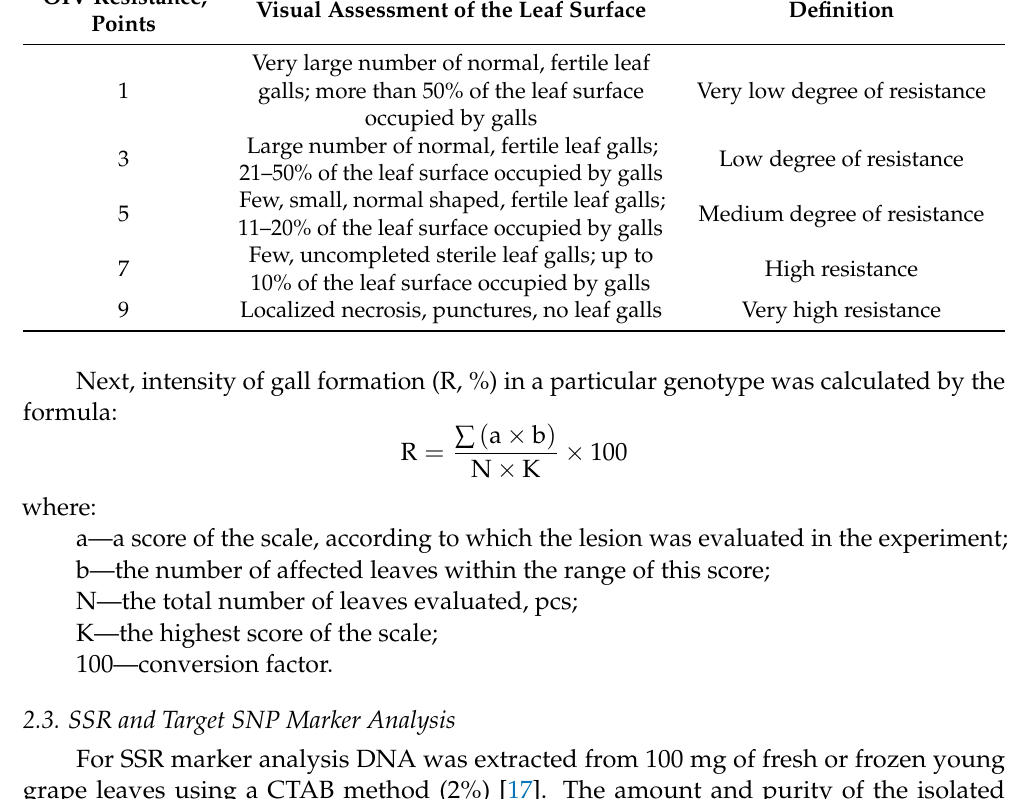
Table 1. Codes OIV-461. Leaf: degree of tolerance to Phylloxera (leaf gall). OIV Resistance,